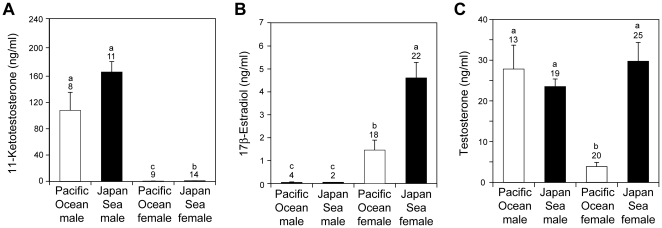
Divergence in sex steroid levels.
Comparison of plasma 11-ketotestosterone (A), 17β estradiol (B), and testosterone (C) between Pacific Ocean and Japan Sea forms of threespine stickleback. The sample size is shown above each column. Lower case letters above the bars indicate samples that are significantly different from each other (Tukey HSD test after ANOVA).